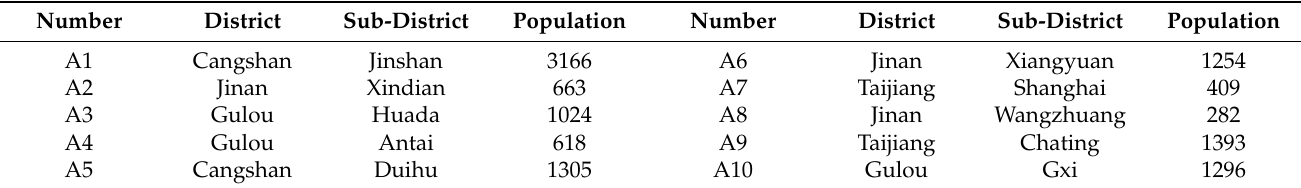
Table 2. Data display for residential.